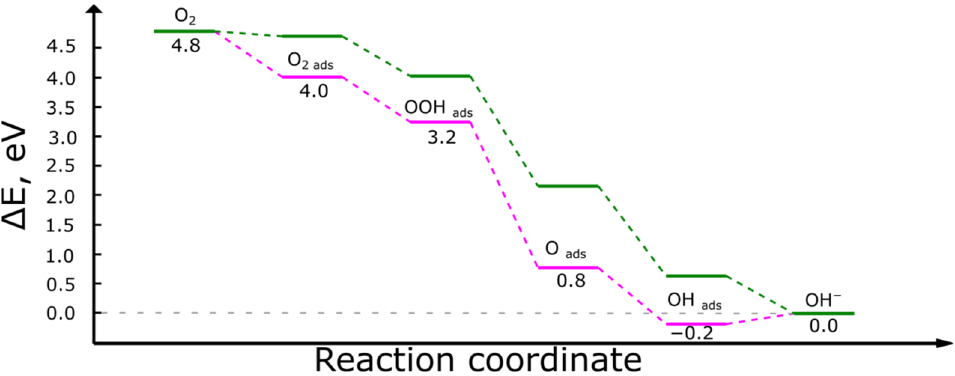
Figure 2. Free energy profile of ORR in free form on CrN 4 (fuchsia) and Cr(OH)N 4 (dark green). Thus, the Cr(OH)N 4 hydroxo form was chosen as the active center of the chromium- containing catalyst, which exhibits catalytic properties. An example of a complex of a cat- alyst and an intermediate is shown in Figure 3.